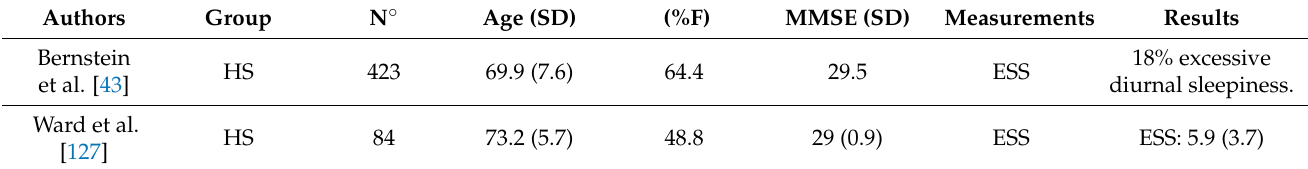
Table 8. Diurnal sleepiness in healthy older age. Summary of all the studies.